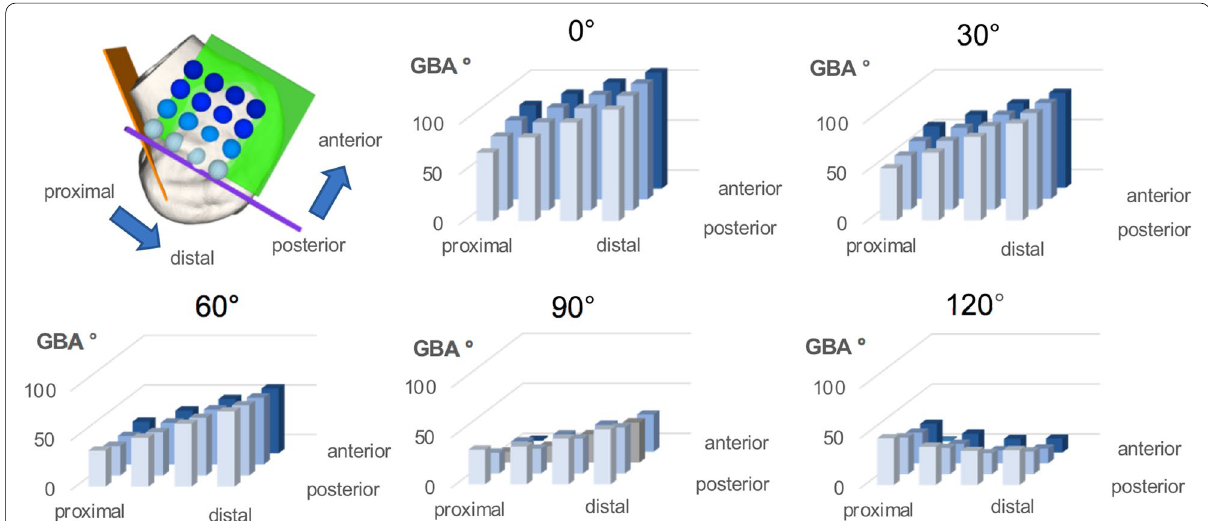
Fig. 6 Mean GBA among flexion grades and femoral exit points. GBA: graft bending angle. 3D bar chart depicts GBA (y-axis) for each flexion° and for each FTE. All bar charts are oriented as in the model on the top left, listing the FTE with respect to the Blumensaat’s line (x-axis (rows; proximal to distal) and z-axis (lines; posterior to